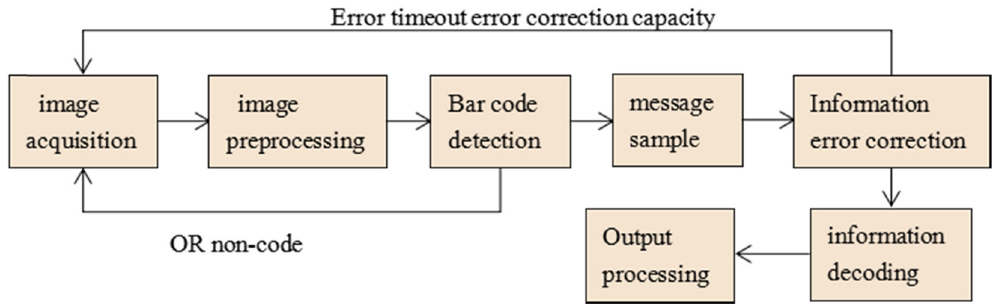
Figure 2: Common operating procedures for QR code identi fi